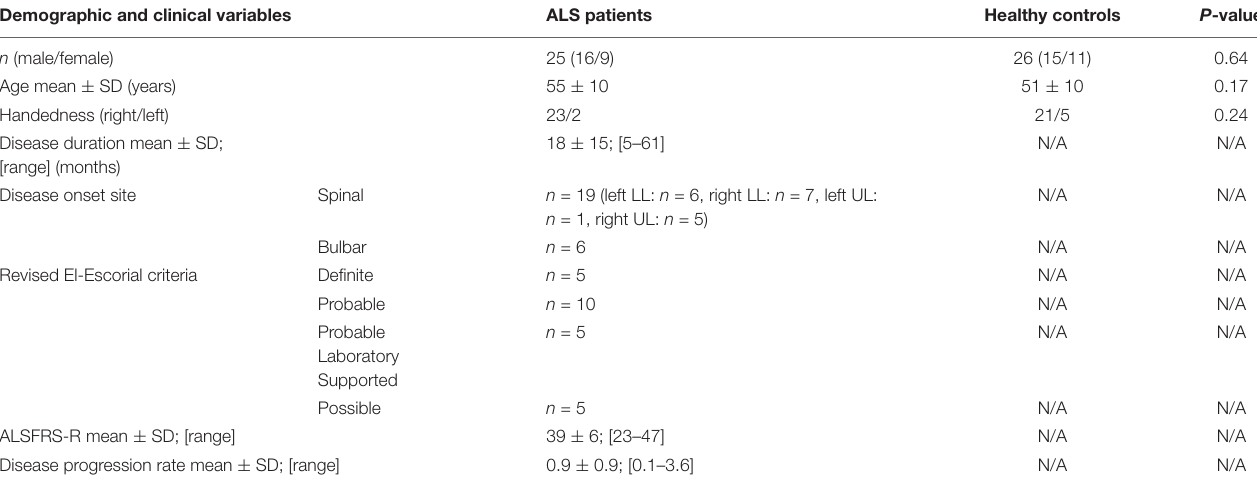
TABLE 1 | Demographic and clinical parameters of ALS patients and controls. Demographic and clinical variables